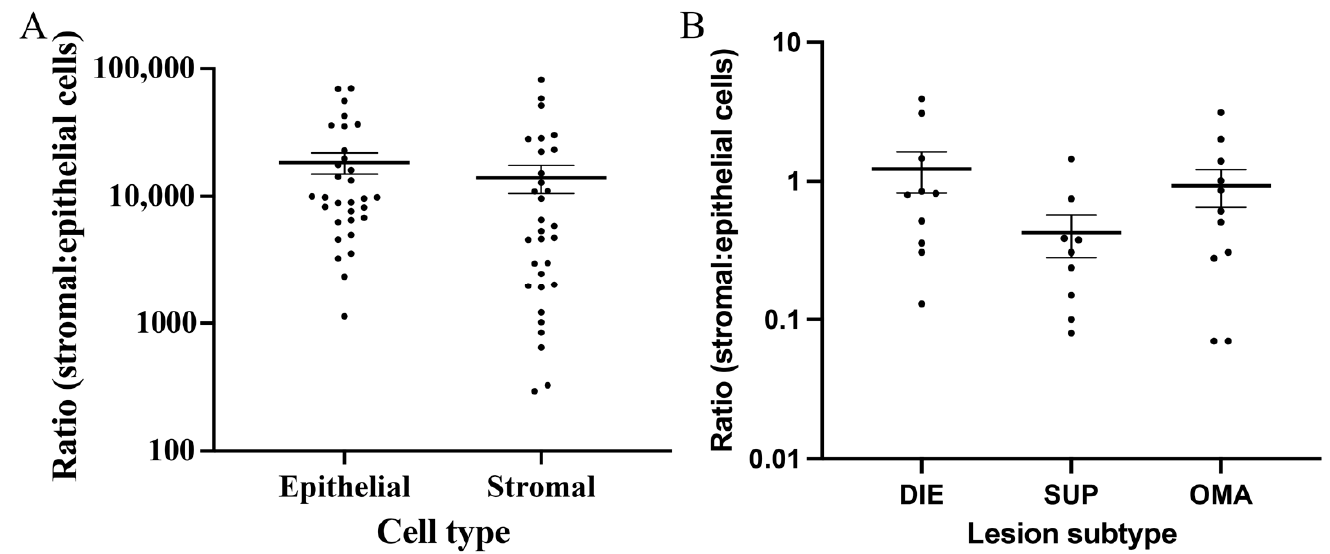
Figure 5. Comparison between epithelial and stromal cell numbers in excised lesions. ( A ) The number of epithelial and stromal cells in all endometriosis foci identified in the excised endometriosis tissue showed no significant difference, with approximately equal numbers of cells in both lesions. ( B ) There was no significant difference in the ratio of stromal:epithelial cells based on lesion subtypes. There was a significant correlation between the ratio of stromal to epithelial cells and dyspareunia.